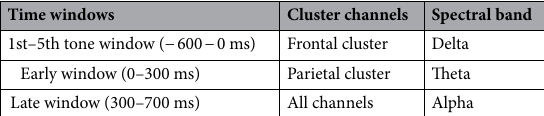
Table 2. Variables used to build the multinomial